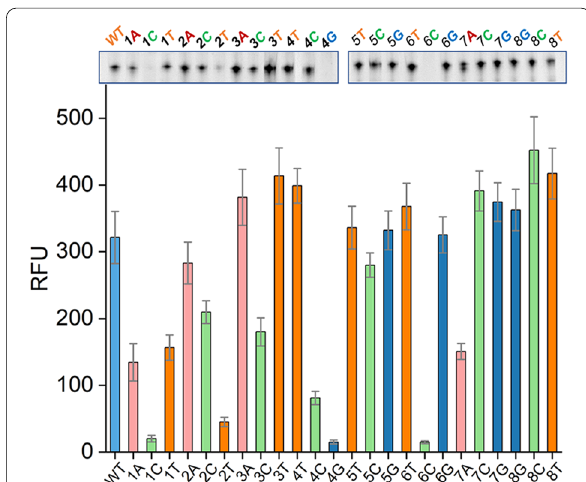
Fig. 6 Transcription efficiency of systematically mutated initially transcribed regions of GFP gene quantified by STAR. The effect of substituting three other base pairs at each nucleotide position of 5 ′ ‑UTR (from 1 to 8) in the DNA template was determined using + + STAR system. The X ‑axis represents different mutants, the Y ‑axis represents the relative fluorescence units. Error bars represent the standard deviation of the triplicate experiments, P < 0.05. The inset shows the results of denaturing polyacrylamide gel electrophoresis analysis of the 60‑min transcription products